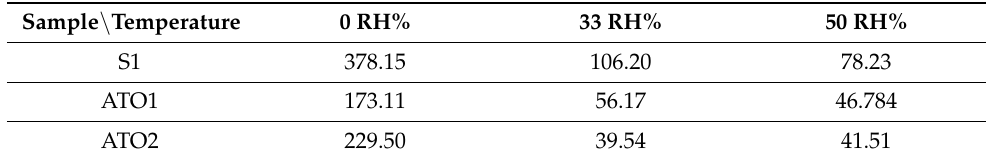
Table 5. Resistance (k Ω ) of samples at different humidity at 300 ◦